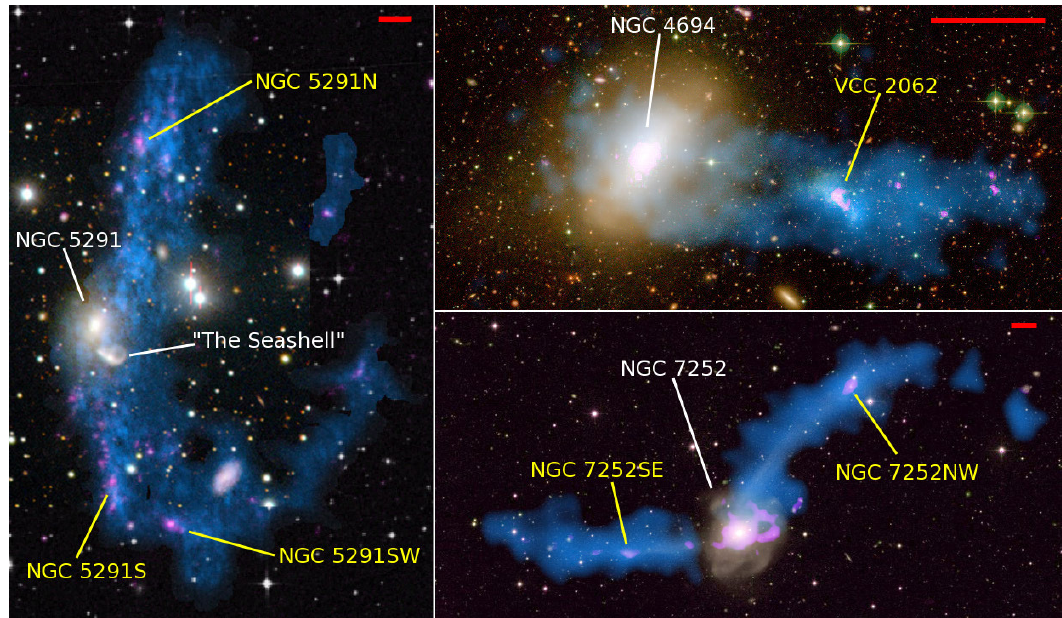
Figure 1. Interacting systems with genuine Tidal Dwarf Galaxies (TDGs, indicated in yellow). Optical images are overlaid with H I emission from the VLA (blue) and FUV emission from GALEX (pink), tracing star-forming regions. The red bar corresponds to ∼ 10 kpc for the assumed